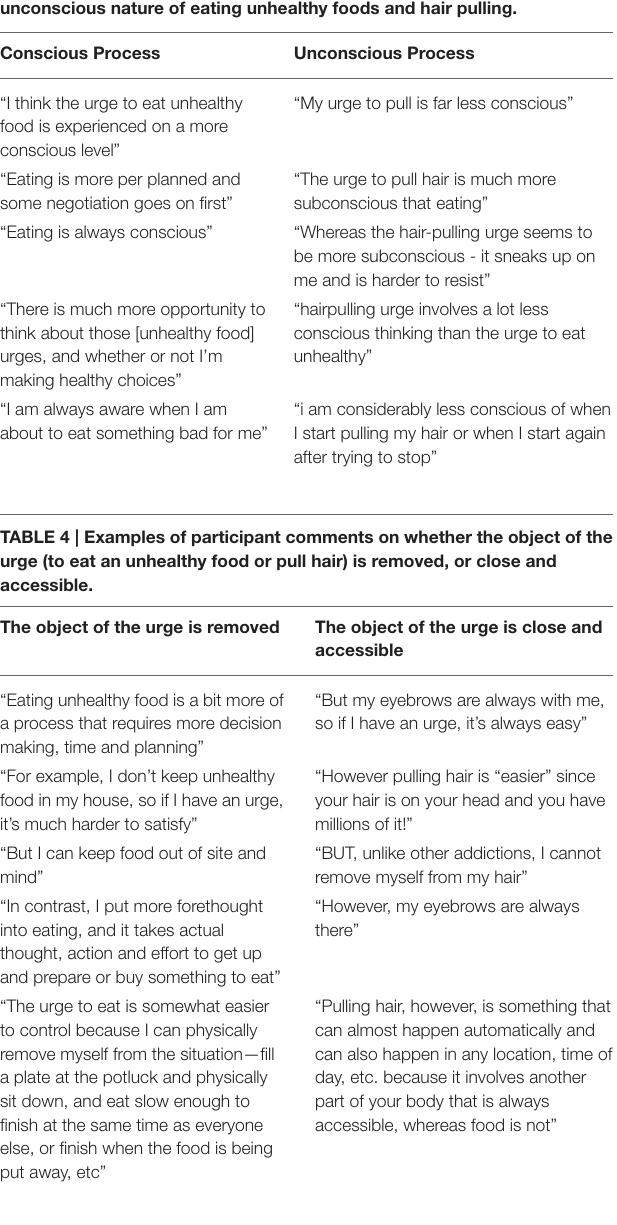
TABLE 3 | Examples of participant comments on the conscious or unconscious nature of eating unhealthy foods and hair pulling.